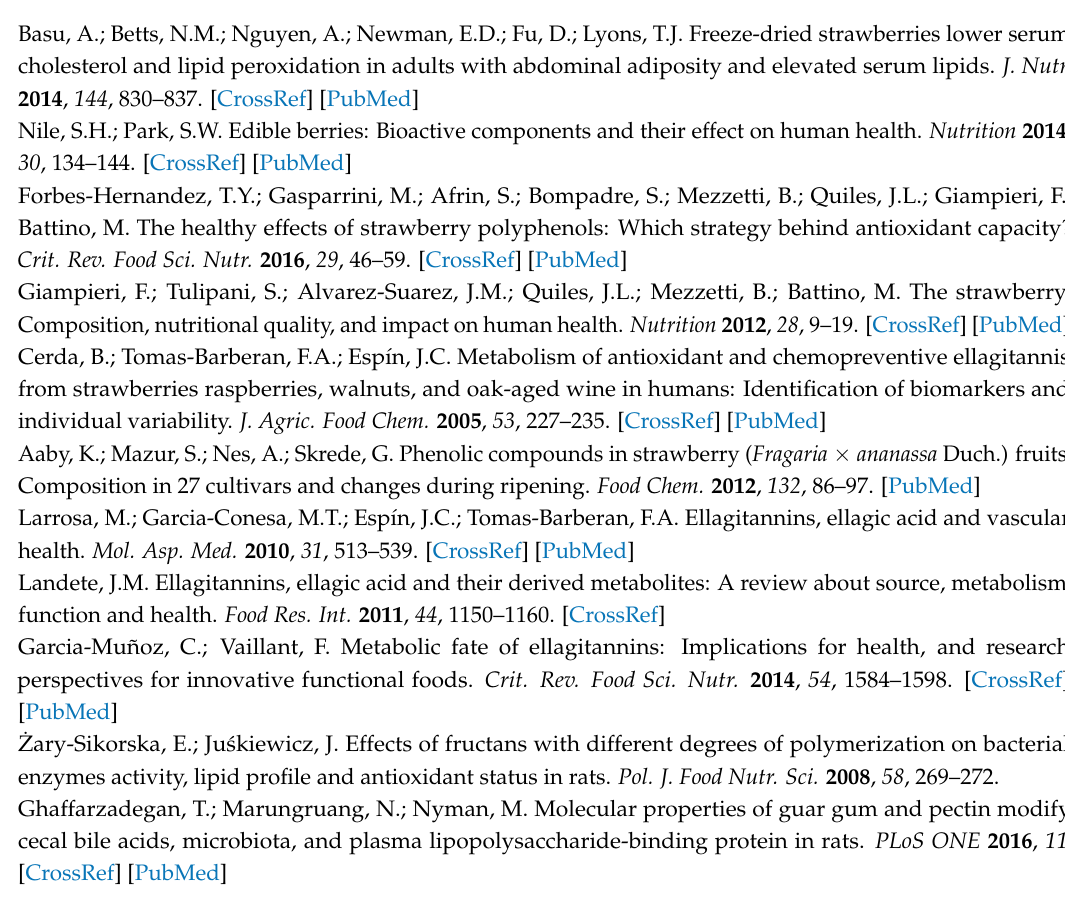
Table S1: Composition of the group-specific diets, Table S2: Large intestinal indices of rats fed experimental